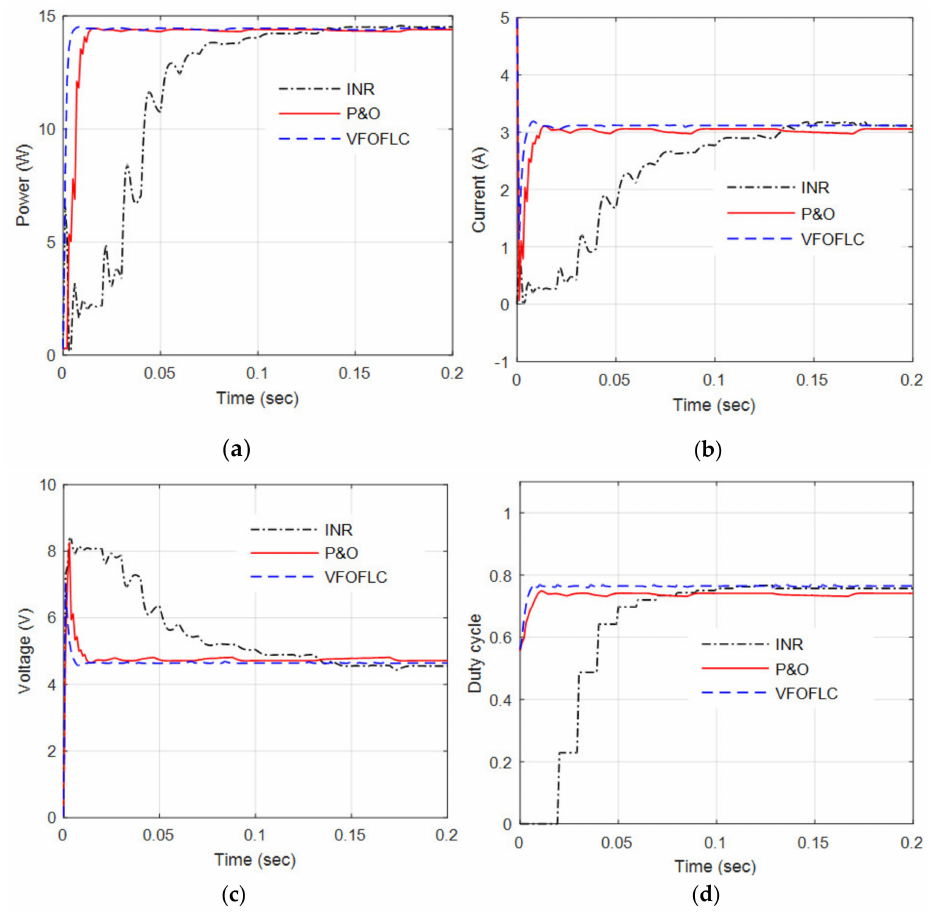
Figure 16. Performance comparison of di ff erent MPPT tracker: ( a ) power output; ( b ) current flow; ( c ) voltage output; ( d ) duty